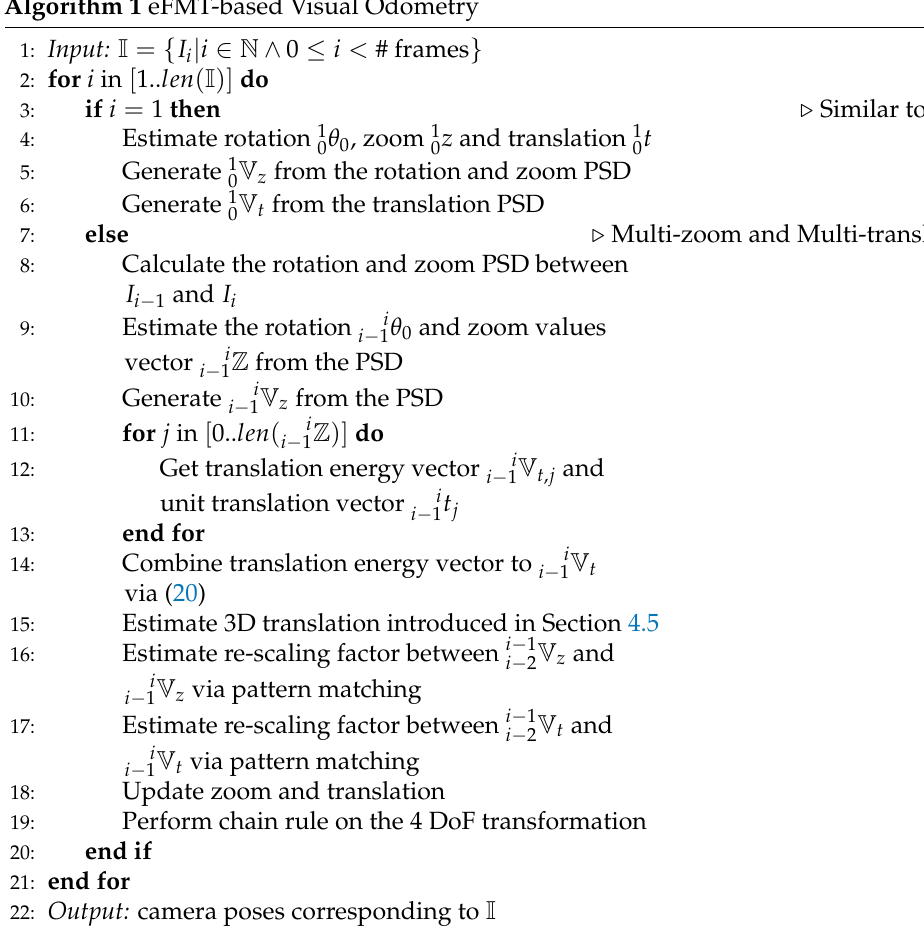
Algorithm 1 eFMT-based Visual